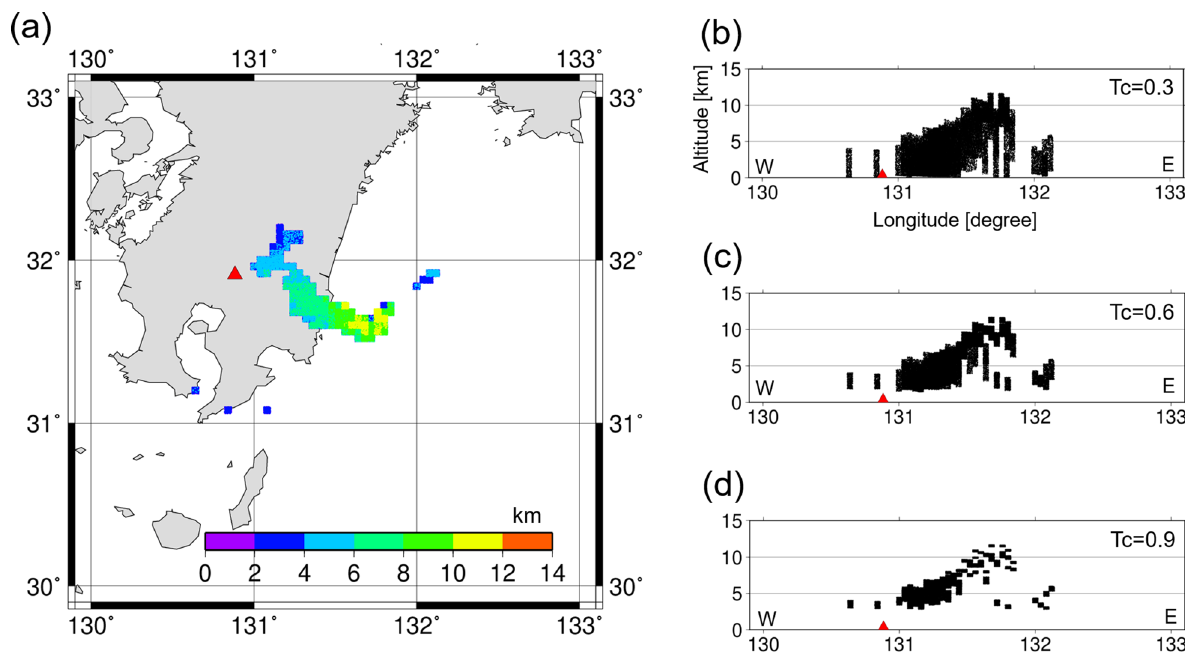
Fig. 2 Initial conditions for JMA–ATM at 20:30 on April 4, 2018 (UTC). a The top height of the tracers in the initial condition for JMA–ATM. b The vertical cross section of the initial condition for T